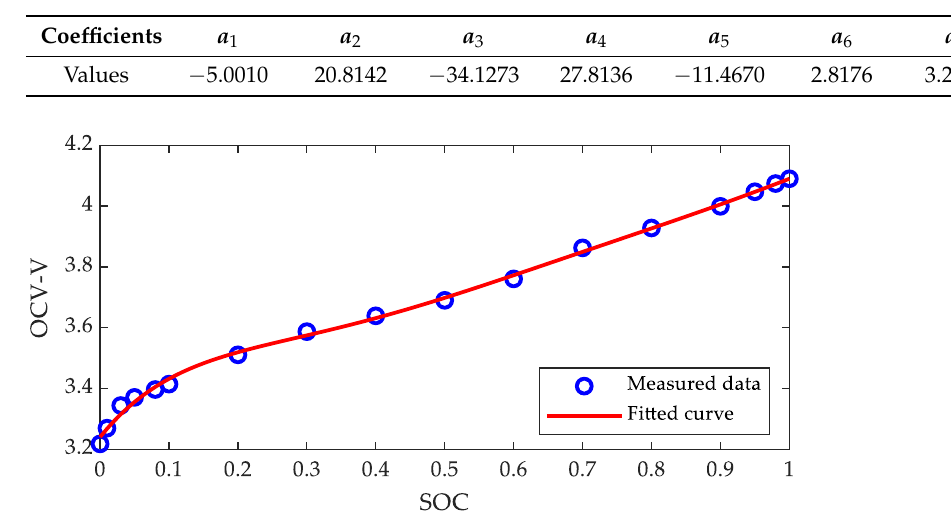
Table 1. Polynomial coefficients of SOC-OCV curve.